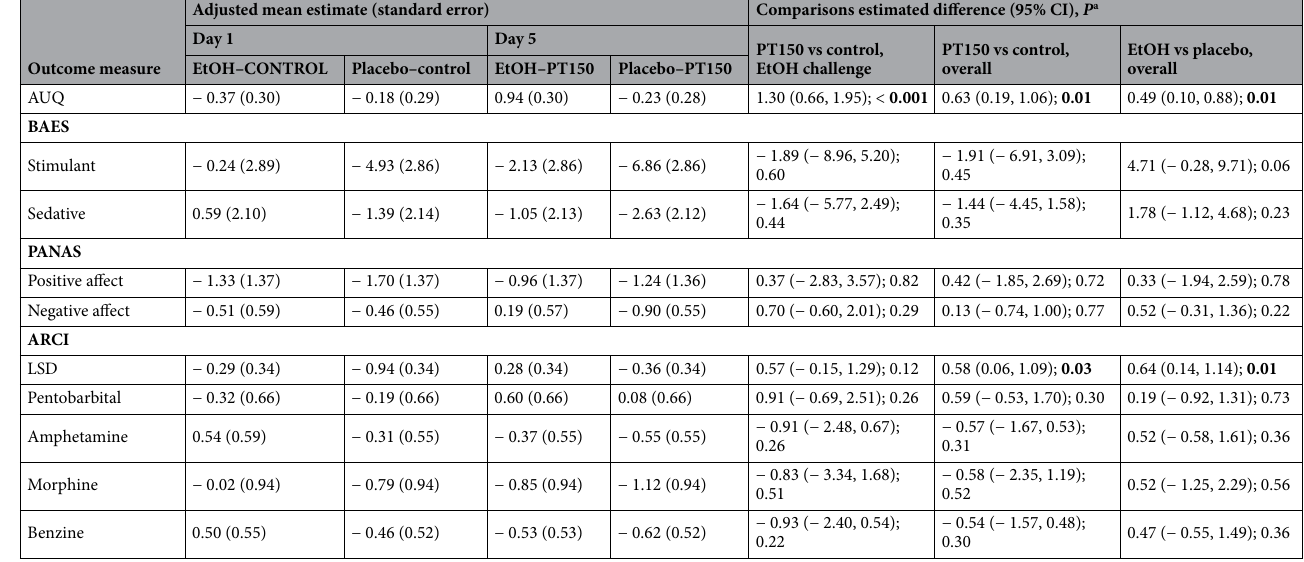
Table 2. PT150 effects on subjective questionnaire outcome measures. a Mixed model used to determine if the mean change from baseline is significantly different between the Day 1 alcohol challenge (no PT150 exposure) and the Day 5 alcohol challenge (PT150 exposure), as well as between Day 1 (no PT150) and Day 5 (PT150), and Placebo and ethanol challenges. Bolded values indicate statistically significant results at a P value ≤ 0.05.